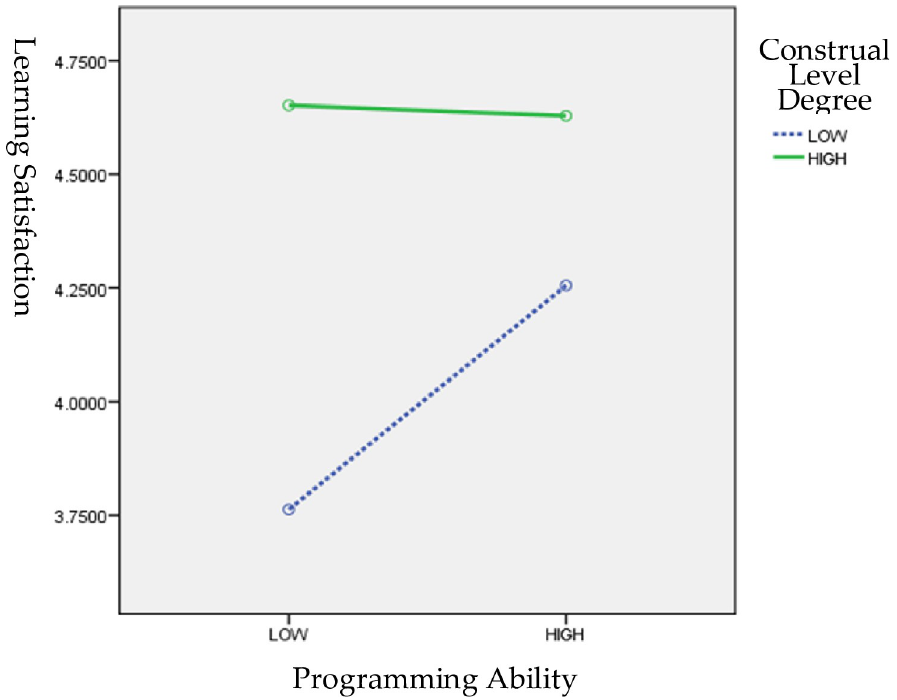
Fig 4. Interrelationships among PA, CL, and